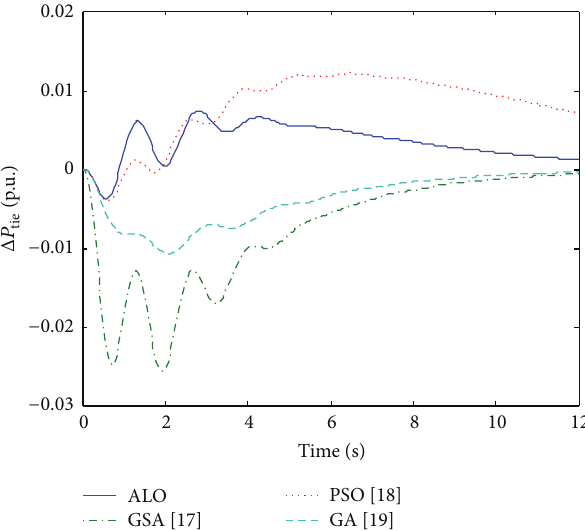
Figure 13: Change in frequency of area 1 by 25% load decreases in area 1.